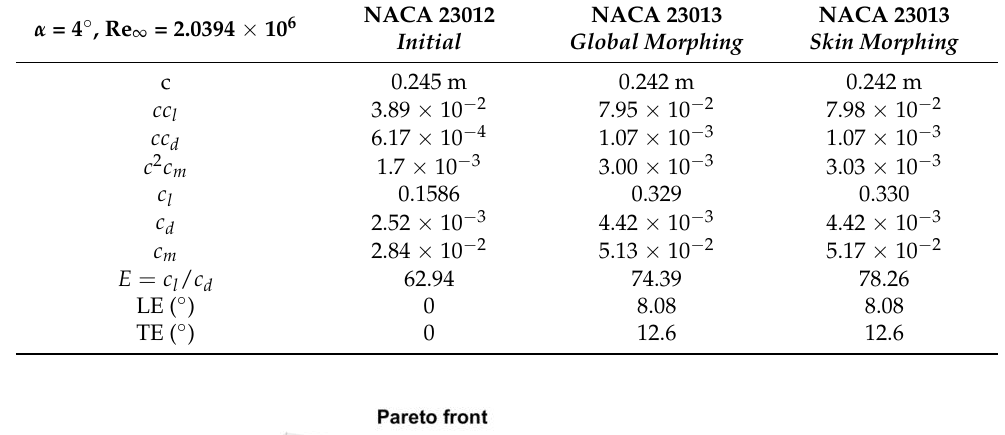
Table 17. Initial and “ global ” morphed NCA 23012.